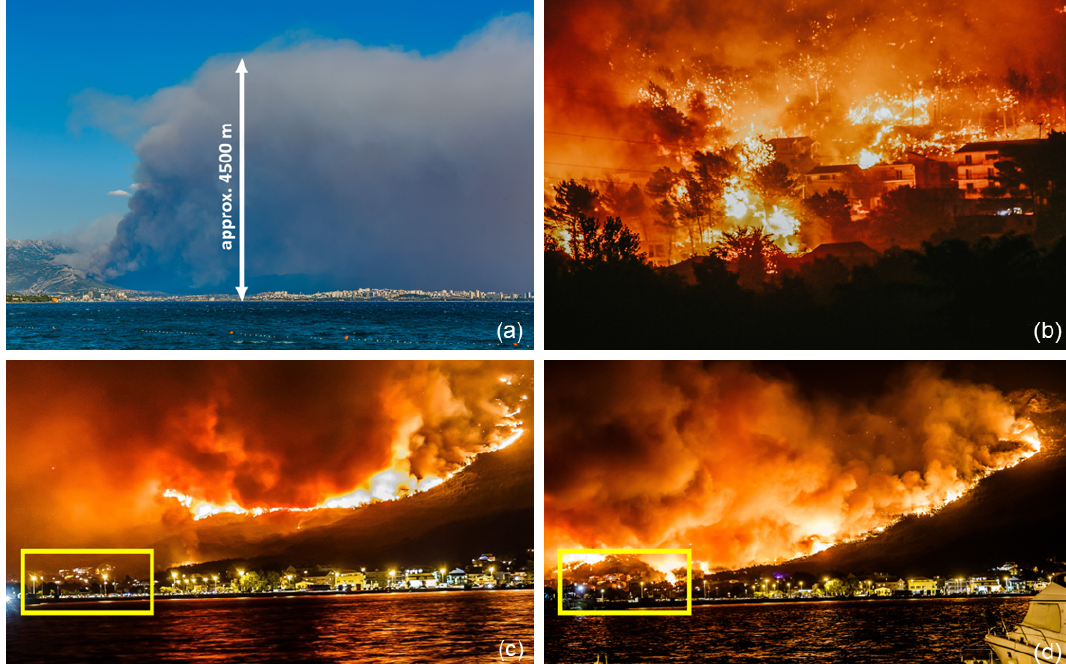
Figure 4. (a) Fire smoke in the afternoon hours (15:09UTC) on 17 July during the SPLIT 3 period, (b) fire burning into the highly populated coastal area, (c) wildfire’s downslope run into the coastal area on the southern side of the hill Perun (A in Fig. 2)at 22:05UTC and (d) 13min later, at 22:18UTC on 17 July, all during the SPLIT 4 period (photos in panels a , c , and d photographed by Zvonimir Barišin and photo in b photographed by Damira Kalajzi´c).